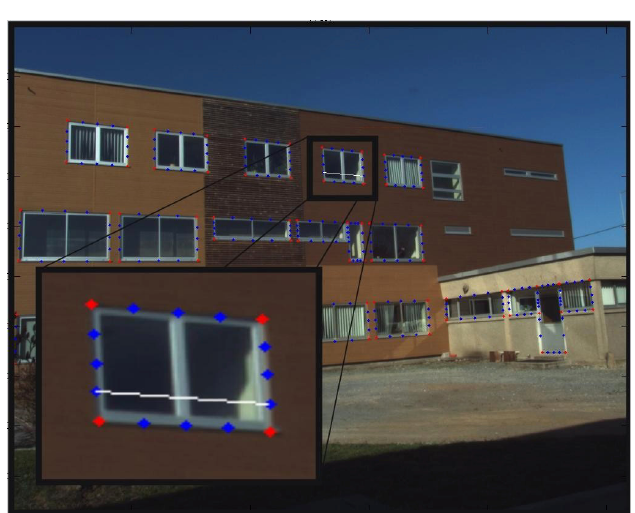
Fig. 12. Picture of the building for windows and blinds opening detection, example: open blind.